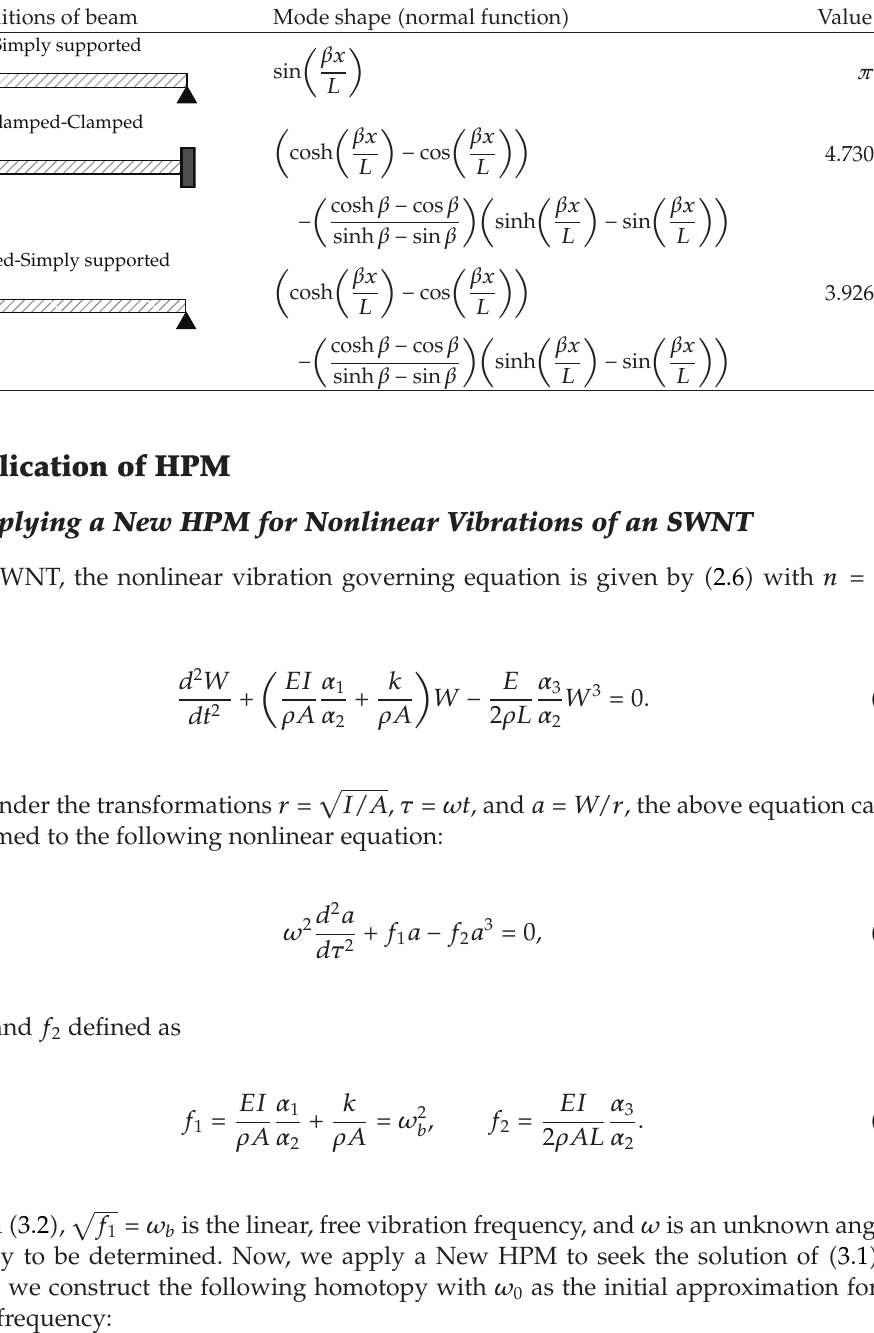
Table 1: Common boundary conditions for the transverse vibration of